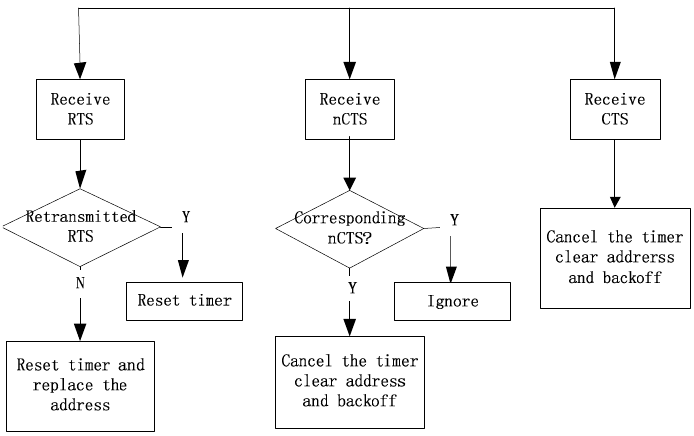
Figure 5. The processing flow of receiving a control frame that does not belong to itself when TET is on.